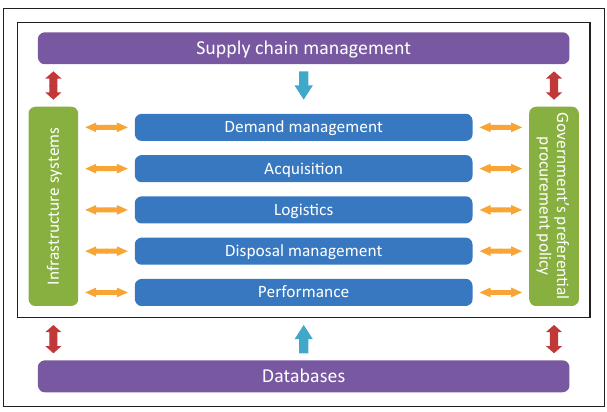
FIGURE 1: Framework of supply chain